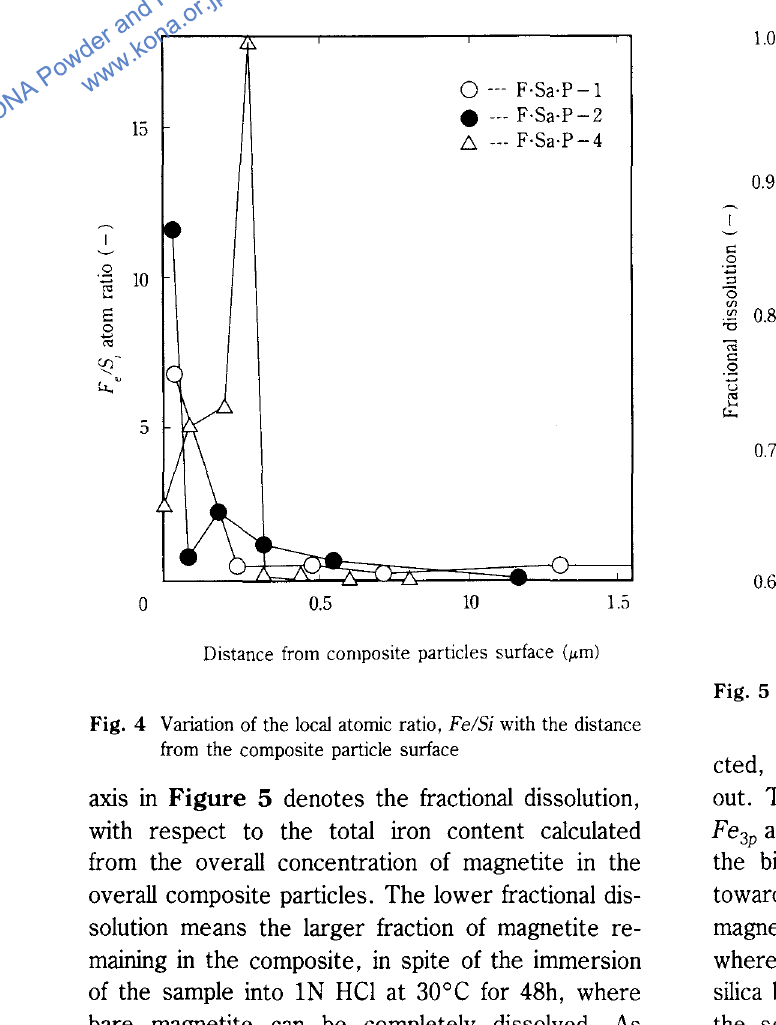
Fig. 4 Variation of the local atomic ratio, F e!Si with the distance from the composite particle surface